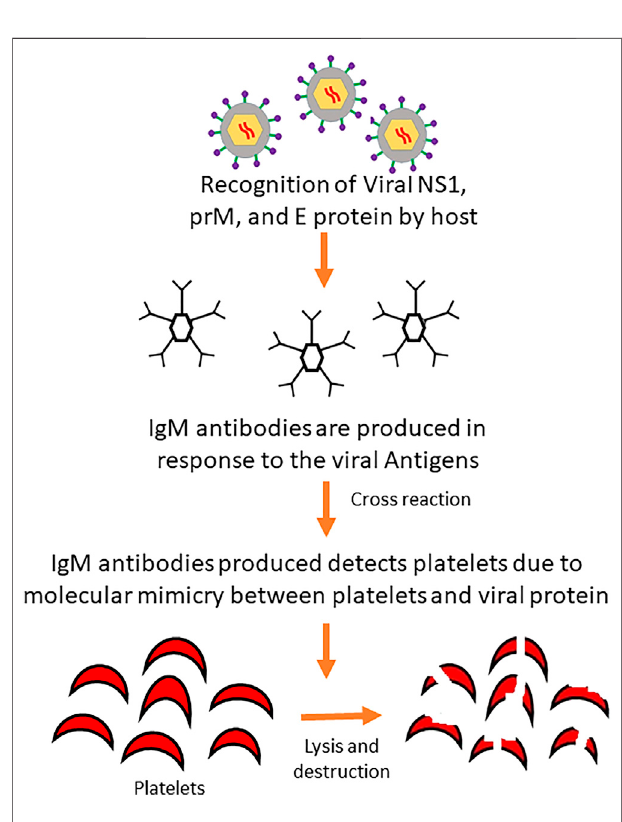
FIGURE 3 | Mechanism of platelet destruction by antibody cross- reaction induced by dengue virus. Invading viral proteins mimics the platelets of the body and are destroyed by IgM antibodies produced upon recognition of viral proteins by the host defense system.